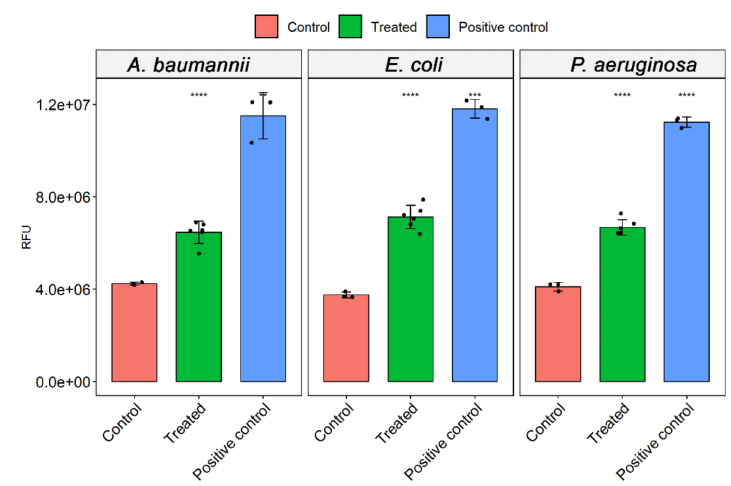
Figure 5. Measurement of reactive oxygen species (ROS.) induced by O 3 on different bacteria after incubation during 10 h. Hydrogen peroxide (1%) was used as a positive control. The data represent the mean and standard deviation of triplicates using different colonies. t -test (***) p < 0.01 and (****) p < 0.001.